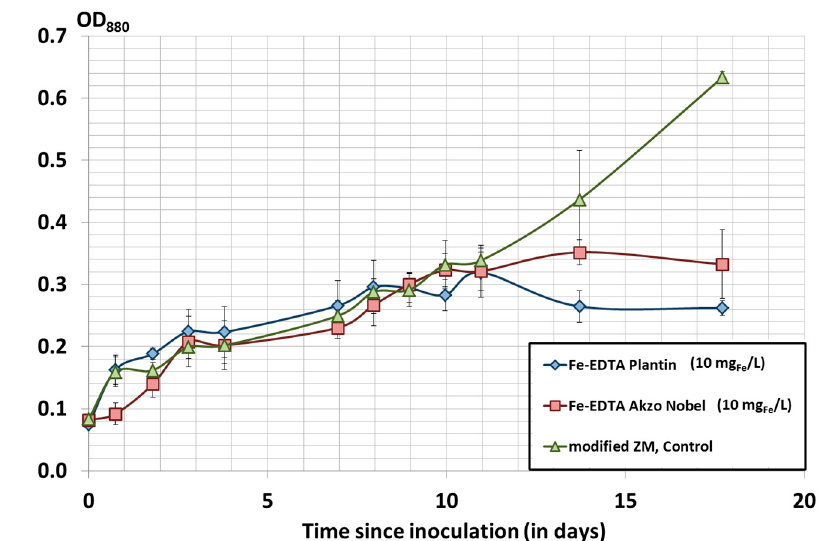
Figure 7. OD 880 measurements of Spirulina grown using Fe-EDTA from Plantin at 10 mg Fe /L (blue diamonds), Fe-EDTA from Akzo-Nobel at 10 mg Fe /L (red squares) and modified ZM (control, 2 mg Fe /L of iron in the form of FeSO 4 ,6H 2 O with 50 mg/L of EDTA, green triangles), in duplicate. Error bars are standard deviations of the biological triplicates. Table 4. Iron mass balance for the Spirulina cultivation experiments using Fe-EDTA formulations from Plantin and Akzo Nobel at 3 and 10 mg Fe /L of iron in comparison to the control, modified ZM.